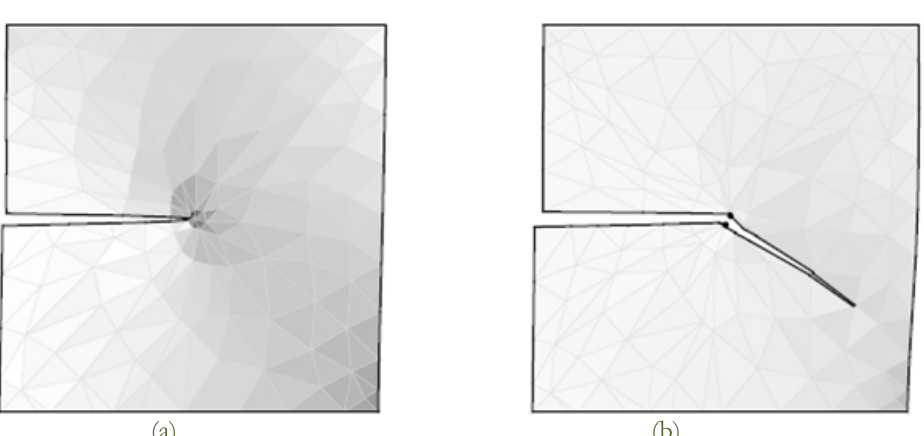
Figure 17: Kinking of a straight crack in mixed mode I & II before kinking (a), after kinking (b).